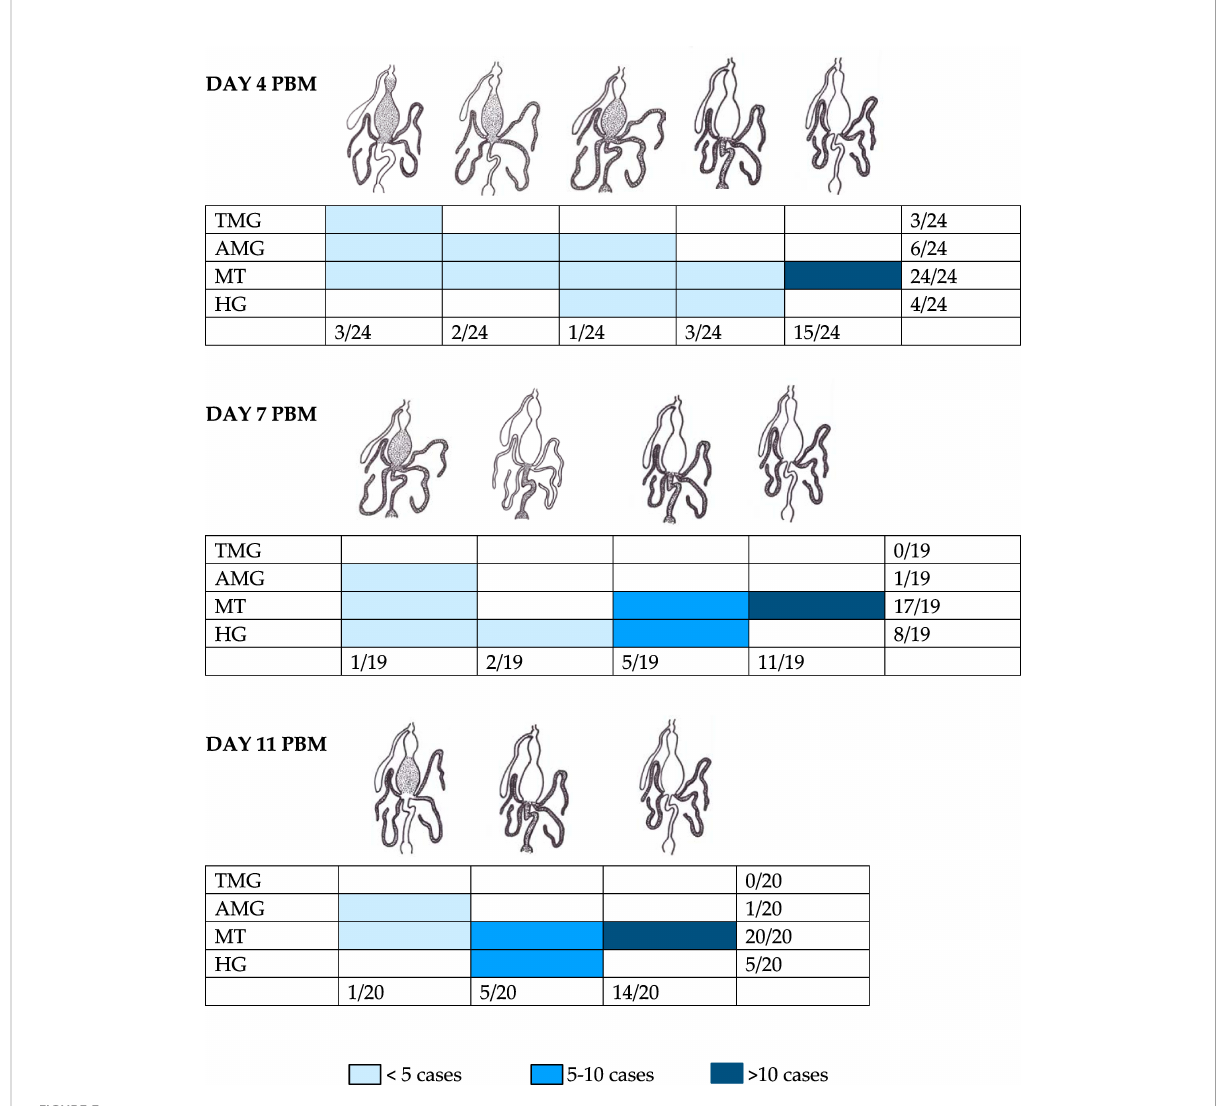
FIGURE 3 Localization of Porcisia deanei in infected Lutzomyia longipalpis. TMG, thoracic midgut; AMG, abdominal midgut; MT, Malpighian tubules; HG,